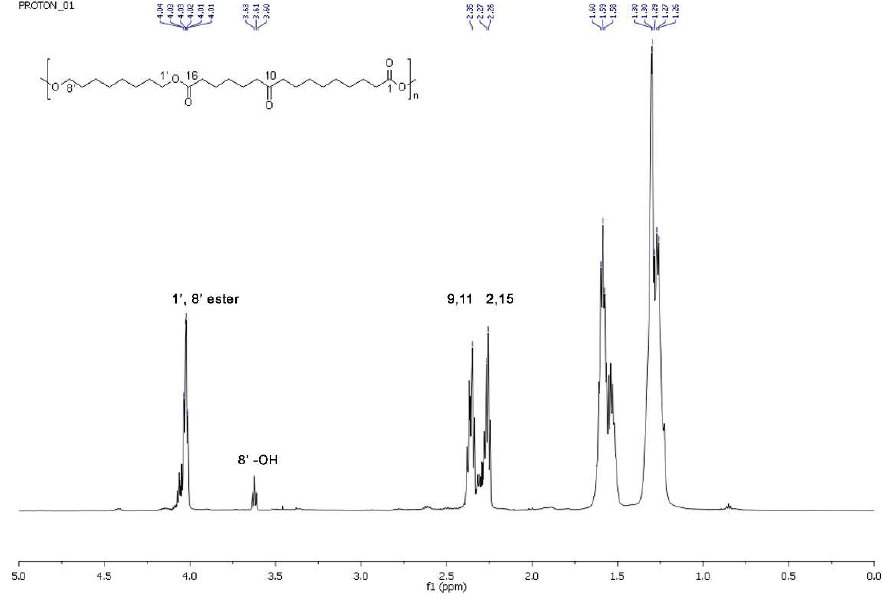
Figure 3. 1 H-NMR spectra of the polycondensation reactions.